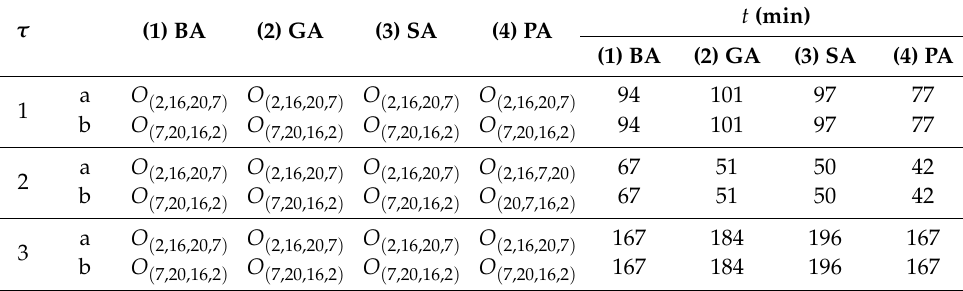
Table 8. A comparison of the traveling time expense of the optimal tour route for each algorithm under the different transportation